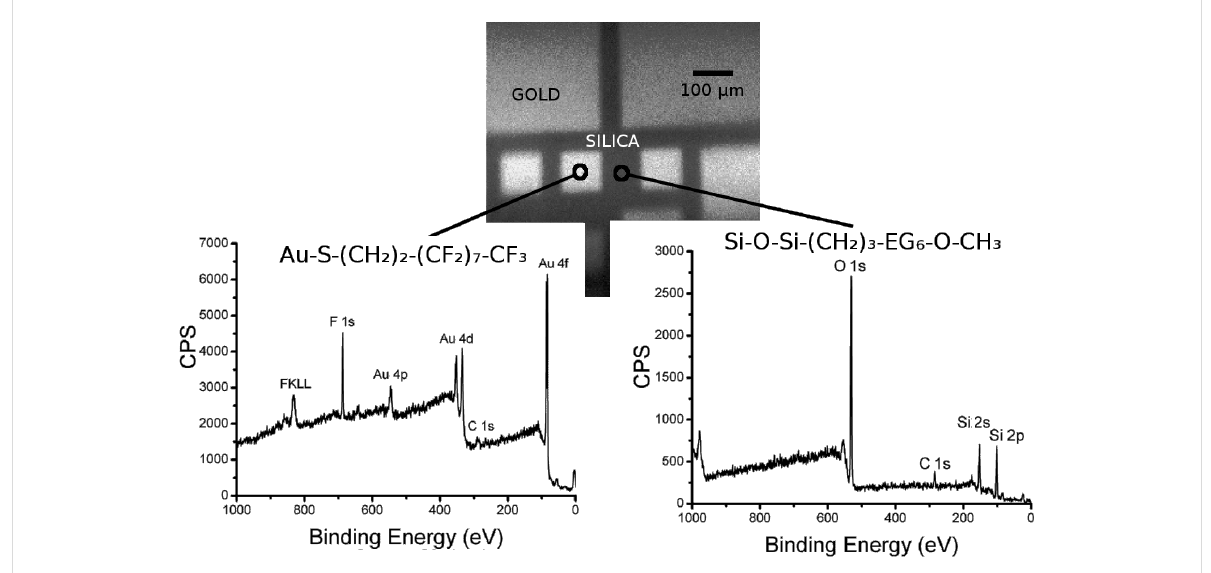
Figure 2: An SXI image and XPS spectra of a micropatterned gold on silica substrate sample, orthogonally functionalized with F-thiol and PEG/Si. The analyzed areas for the spectra were roughly 10 μ m and their approximate localization is indicated on the image. The scale bar in the image is 100 µm.